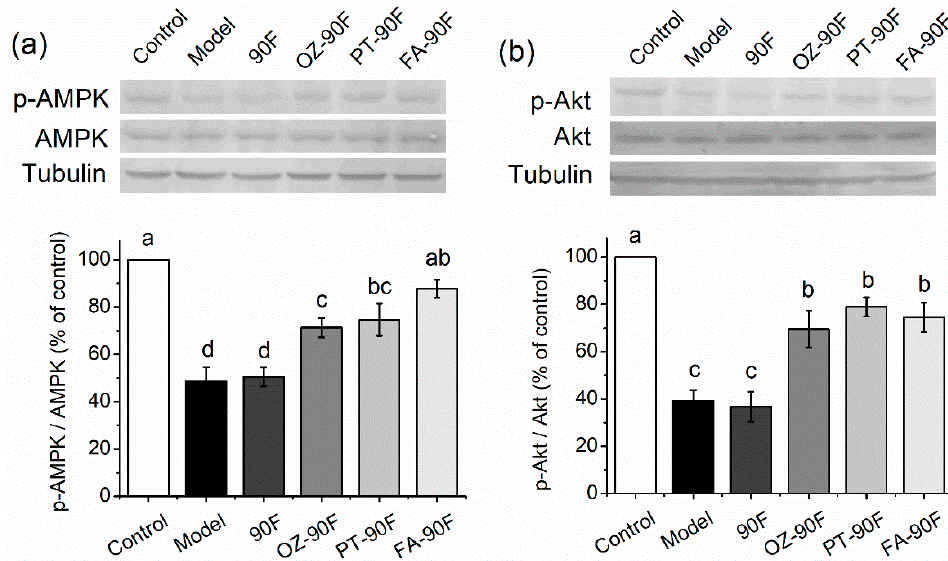
Figure 7. Western blot analysis of AMPK ( a ) and Akt ( b ) expressions in liver tissues. Proteins were extracted from the liver tissues of treated rats. Data are presented as mean ± SEM ( n = 3). Mean values from the same week with different letters are significantly different ( p < 0.05). 90F, 90% wheat flour; OZ-90F, γ -oryzanol-enriched 90% wheat flour; PT-90F, phytosterol-enriched 90% wheat flour; FA-90F, ferulic acid-enriched 90% wheat flour.